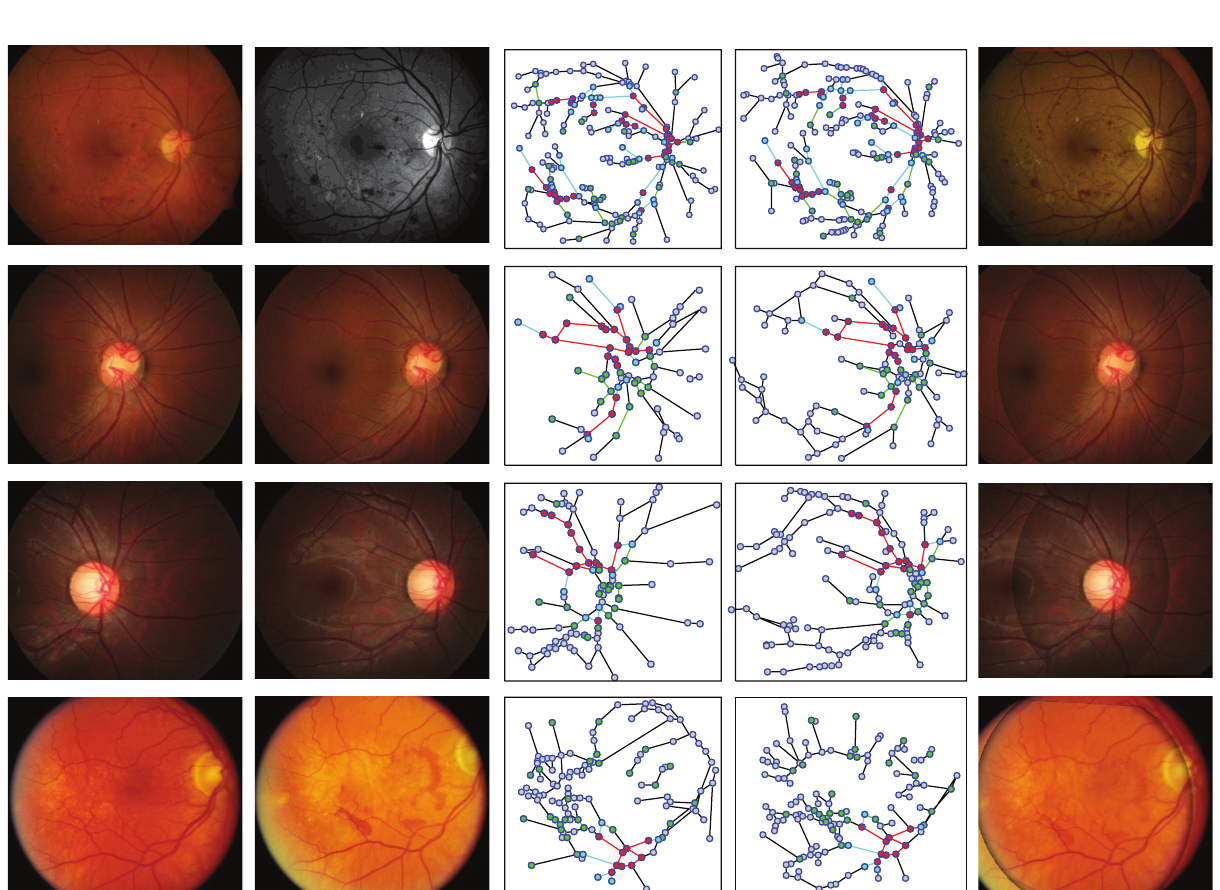
Figure 11: Some image registration results with GM-ICP, from left to right each column represents reference image, floating image, reference VSG, floating VSG, and fused image,